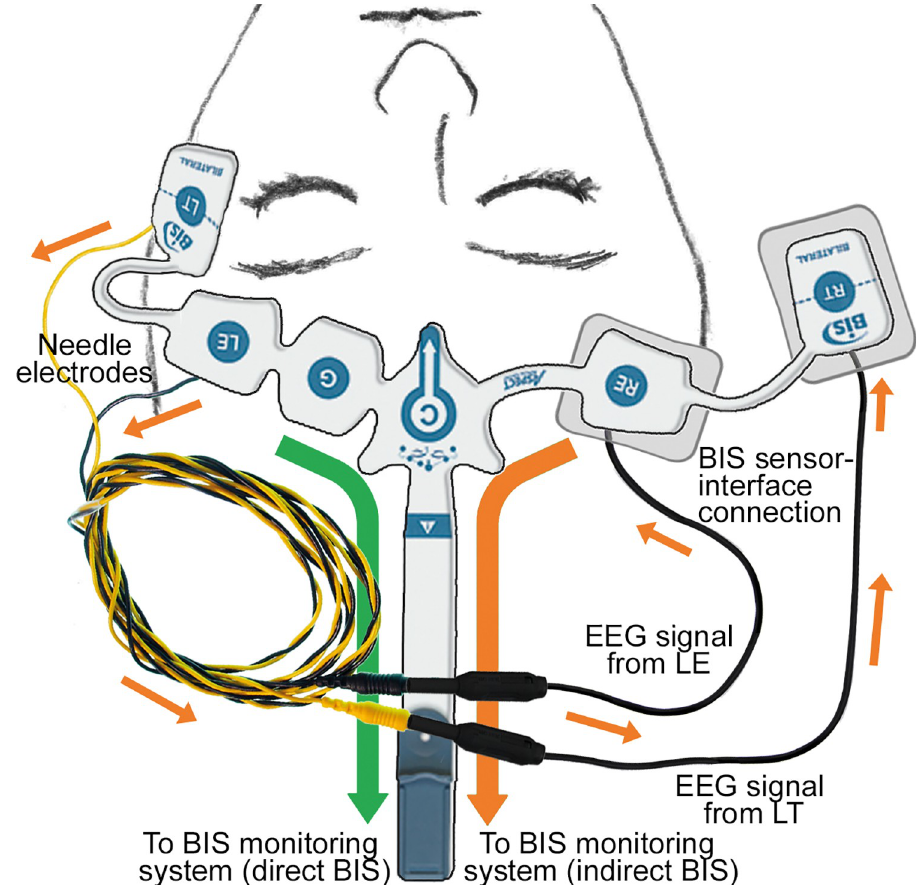
Fig 2. The interface device setting for direct and indirect recording. The setting for the clinical study 2 using BIS ™ Bilateral sensors. Left BIS ™ Bilateral sensor is attached at the forehead following the manufacturer’s instruction. Two needle-electrodes are inserted subcutaneously adjacent to the LE and LT electrodes and connected to the RE and RT side via the interface device. Arrows designate the signal paths (orange arrows: indirect bispectral index (BIS) recording; green arrows: direct BIS recording). BIS: bispectral index, EEG: